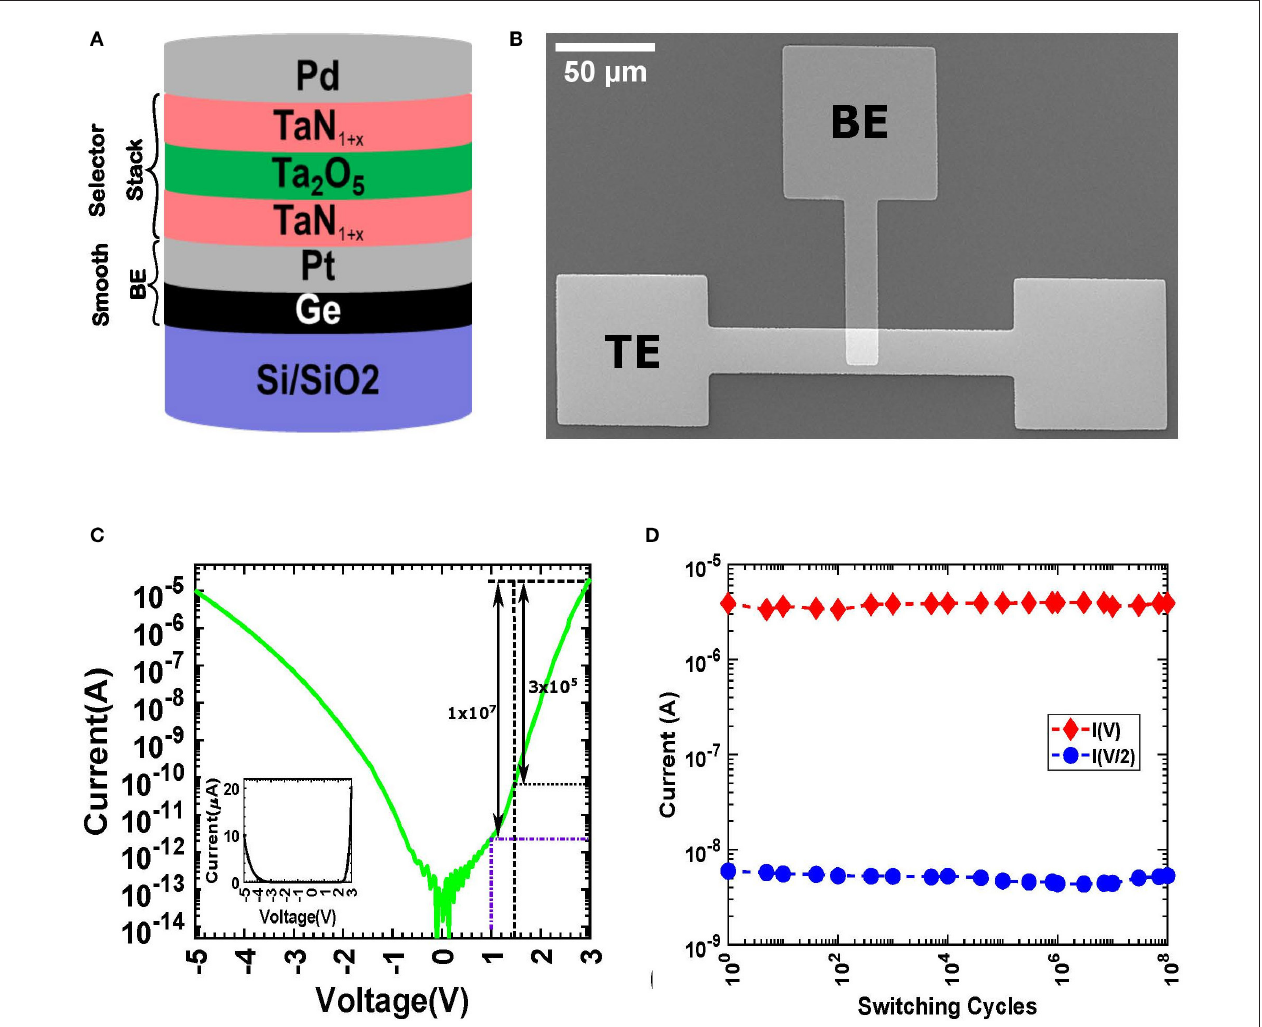
FIGURE 3 | Trilayer tunneling selector device performance. (A) Schematic of the proposed selector device. (B) Scanning electron microscopy image showing a top-view image of the fabricated device. (C) A typical non-linear I–V curve of the selector device. The inset shows a linear plot of the I–V curve. (D) Endurance data measured up to 100 million